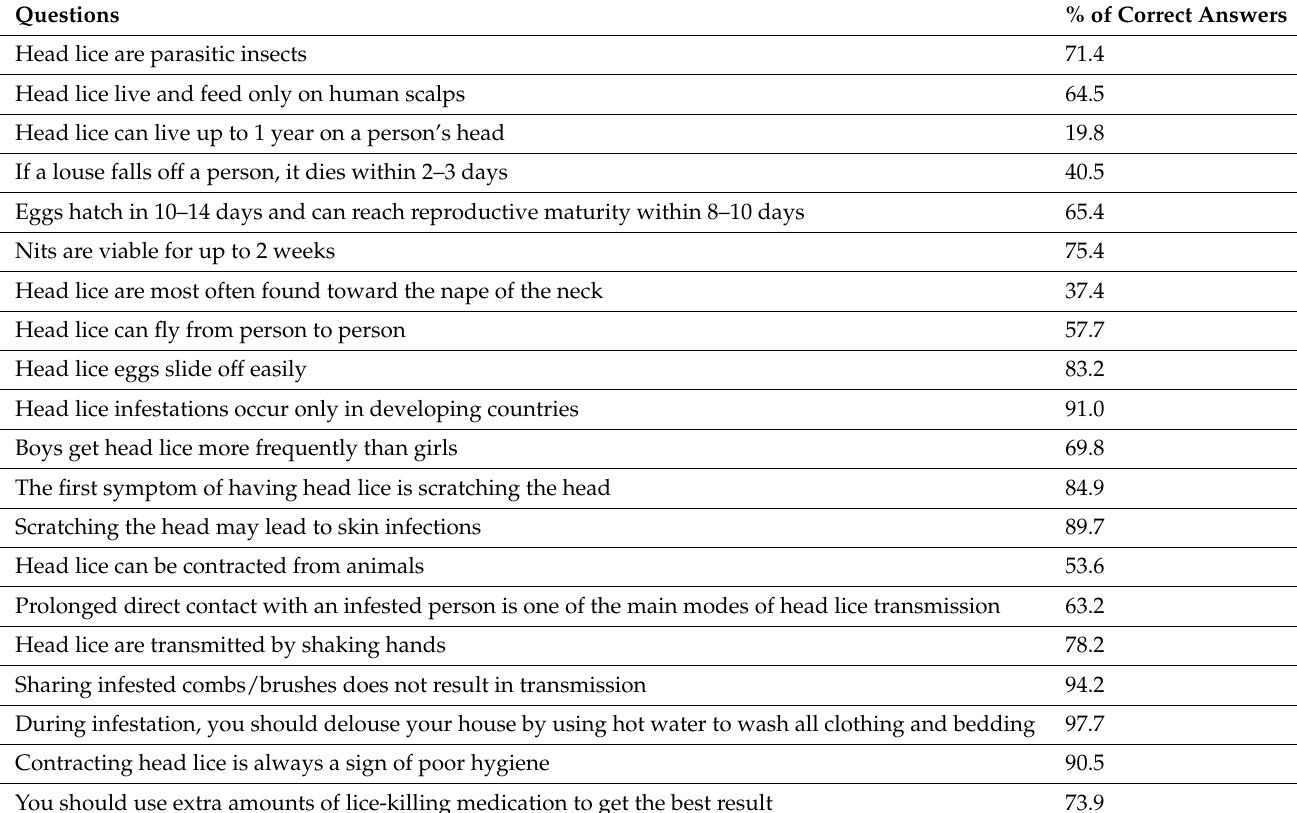
Table 4. Data awareness of Estonian parents about pediculosis and its prevalence.